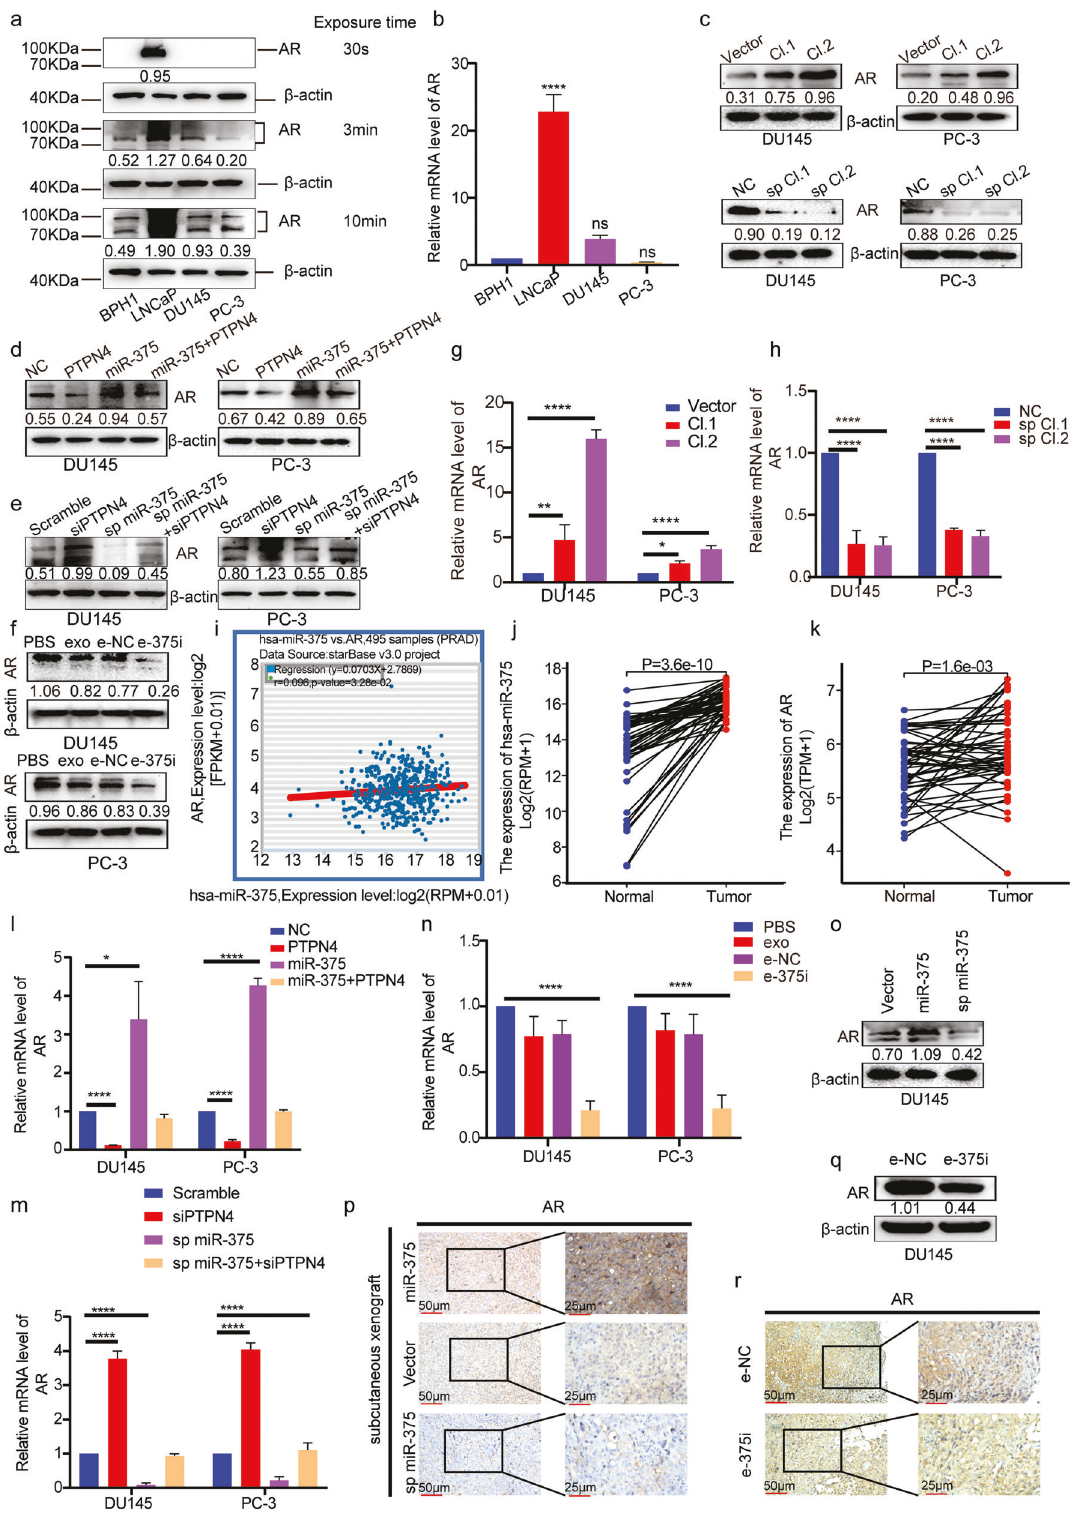
of PTPN4 was able to reverse the suppression effect of miR-375 depletion on AR mRNA (Fig. 8m). As expected, e-375i treatment attenuated the expression of AR mRNA (Fig. 8n). Our in vitro fi ndings con fi rmed that AR was signi fi cantly enhanced in miR-375- overexpressing tumors but decreased in miR-375-knockdown tumors (Fig. 8o). The western blot-based readouts were